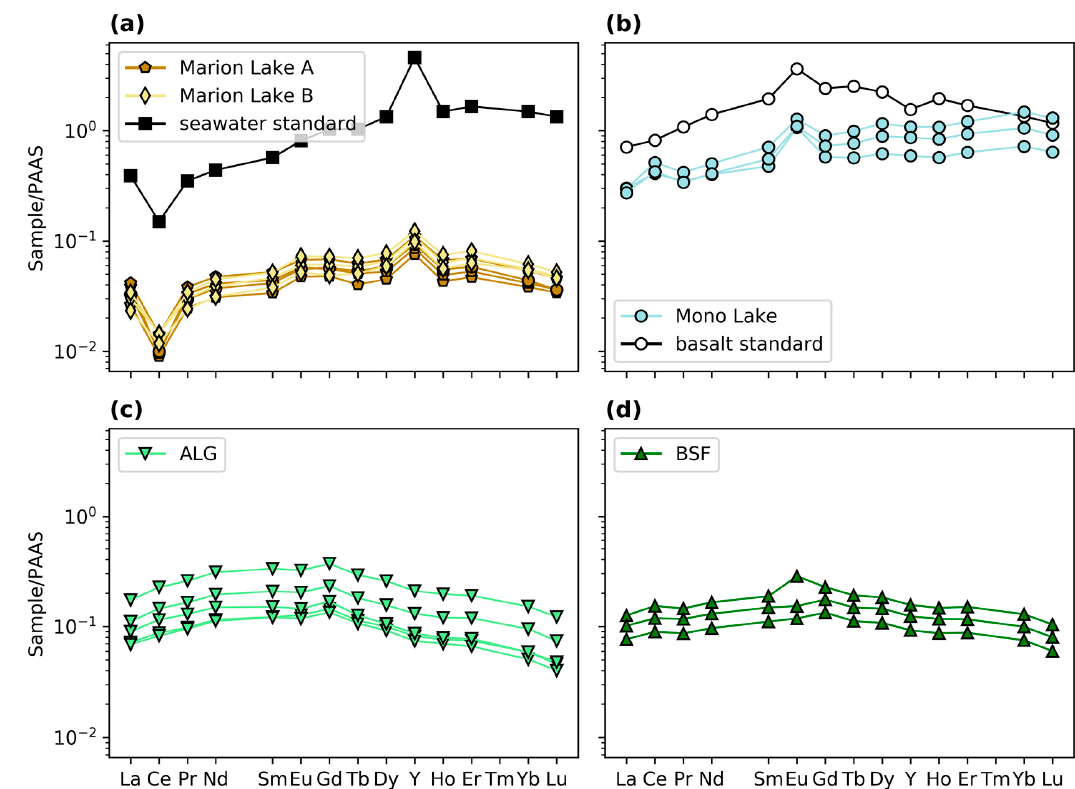
Figure 6. REY patterns of microbialites from ( a ) Marion Lake with REY distribution of a seawater standard [71], ( b ) Mono Lake with a basalt standard (BHVO-2), and ancient microbialites from ( c ) Andrée Land Group (ALG) and ( d ) Bitter Springs Formation.